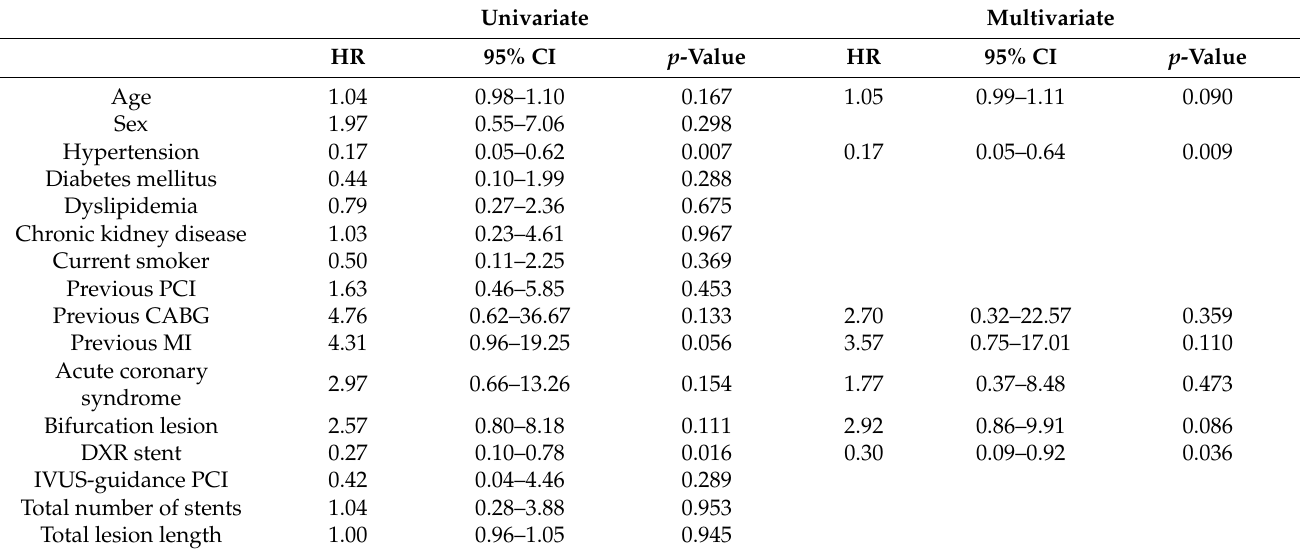
Table 4. Variables associated with target lesion